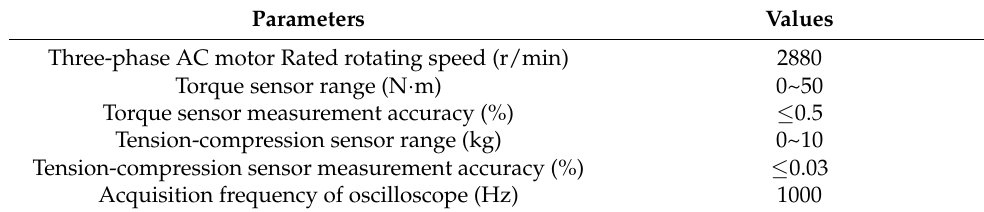
Table 1. Main technical parameters of test equipment.